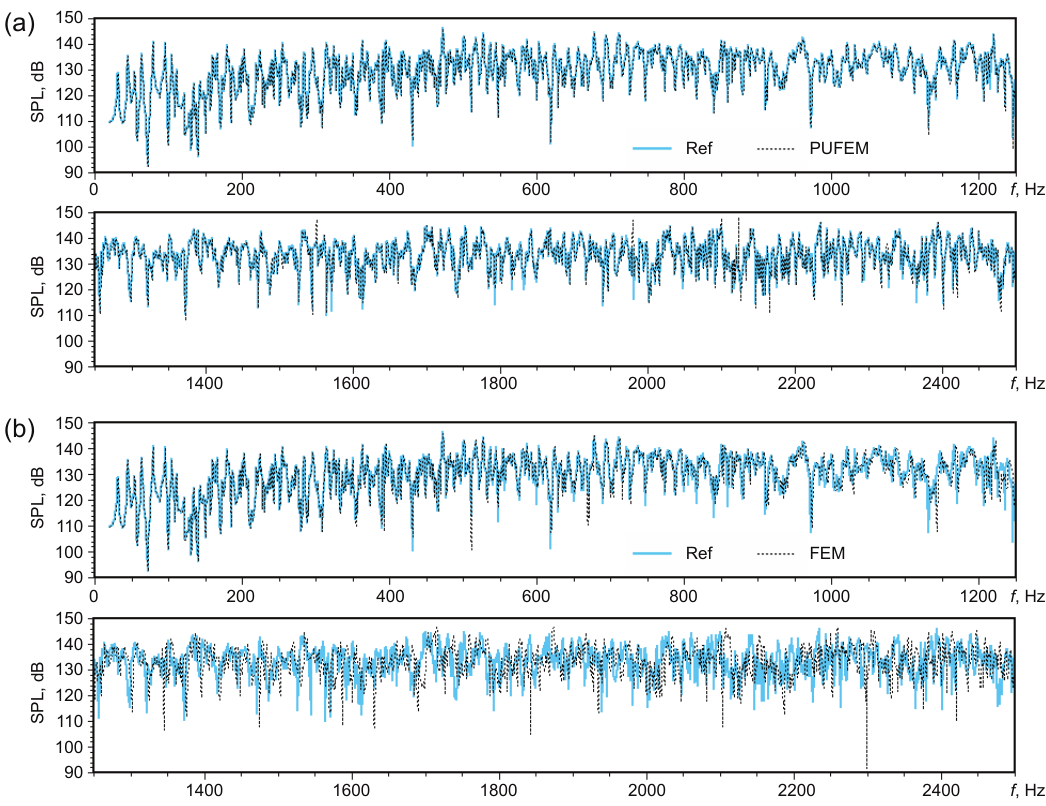
Figure 4. Comparison of frequency responses at R1: ( a ) reference solution (Ref) vs. PUFEM ( C = 13, Mesh 2), and ( b ) reference solution vs. standard FEM (0.01 m mesh).